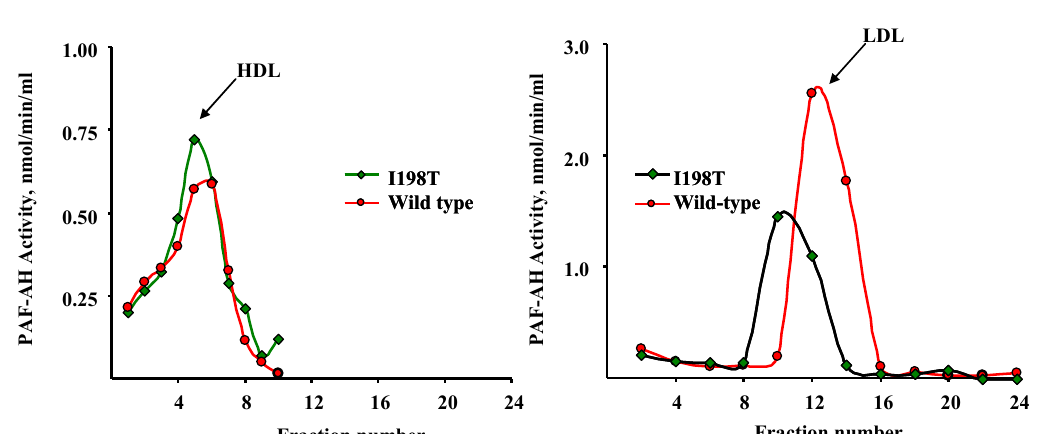
The top panel depicts amino acid sequences around I198 across several species. The bottom panels show that recombinant human I198T binds to HDL (left panel) and LDL (right panel) in manners comparable to those of wild-type